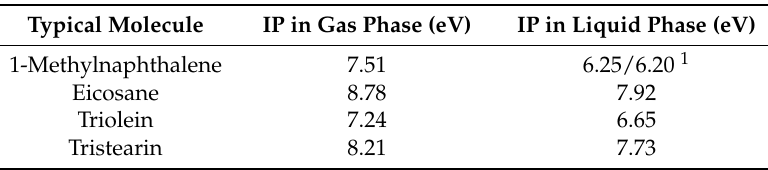
Table 3. Ionization potentials of typical molecules.